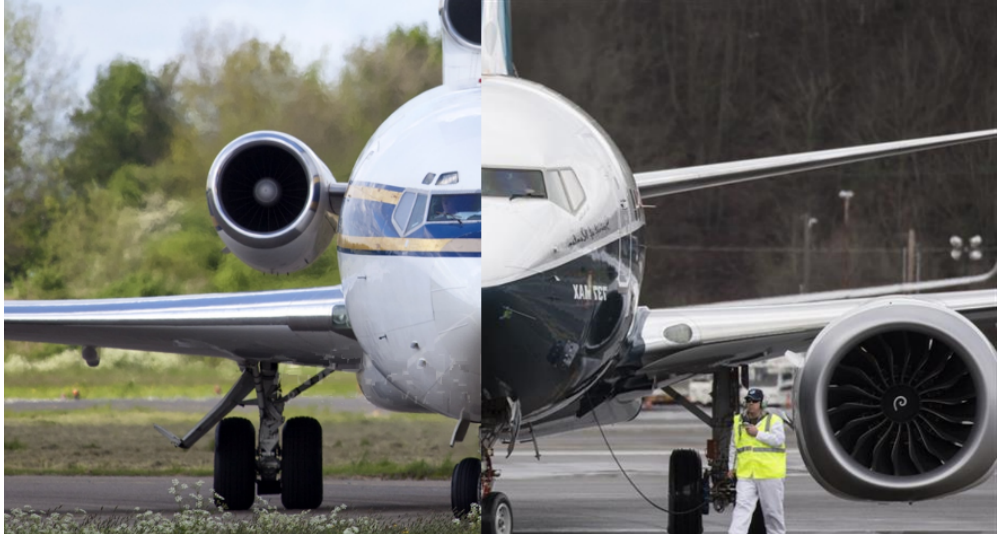
Figure 6. Boeing 727-200 ( left ) side-by-side to a Boeing 737 Max 7 ( right